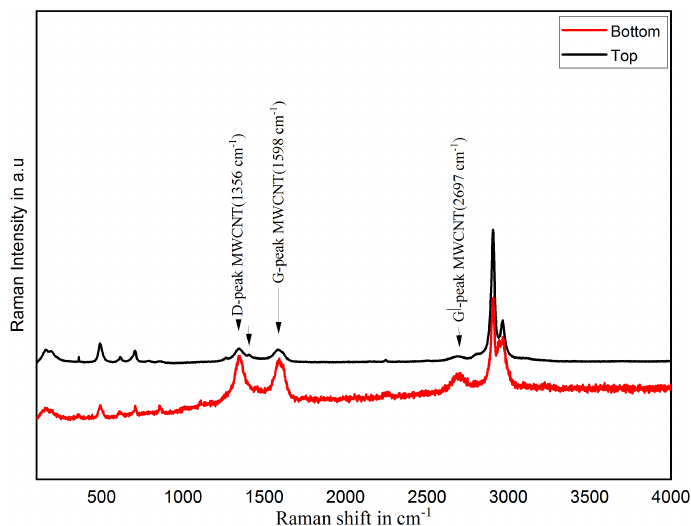
Figure 2. Raman spectra MWCNT/PDMS nanocomposite